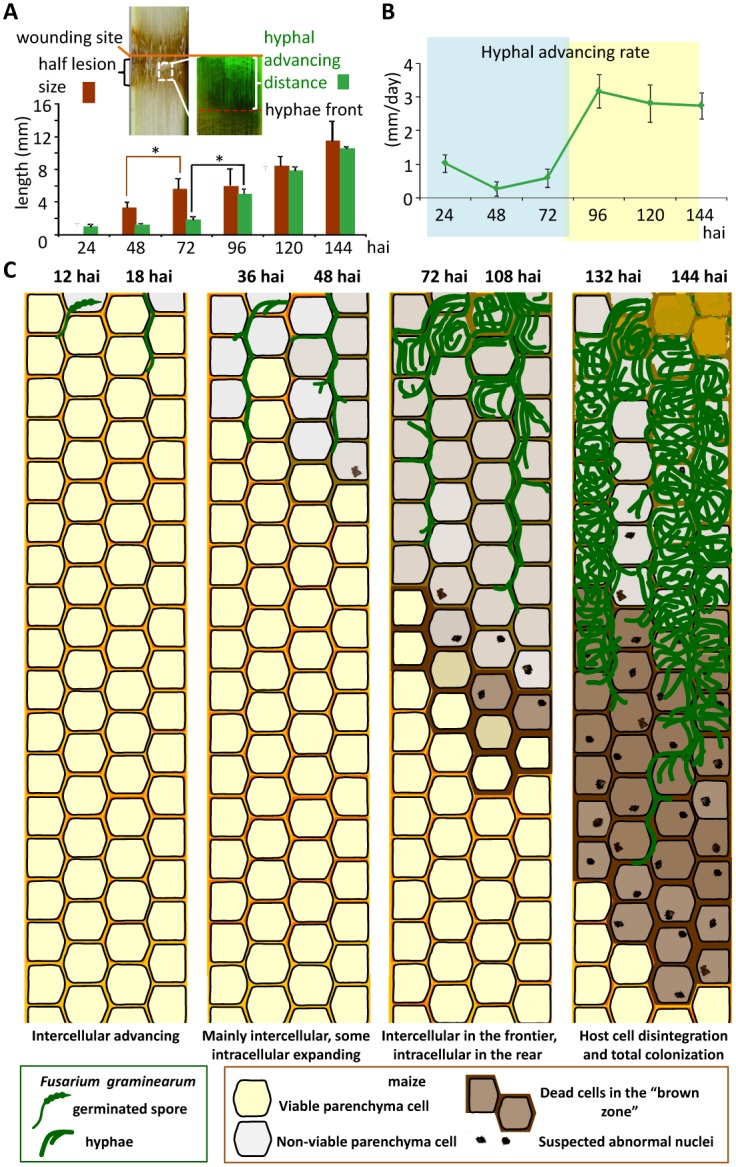
Measurements and diagram of maize stalk infection process.(A) Measurements of half lesion size and hyphal advance distances. Error bars indicate SD. *Significant difference by Student’s t-test (P < 0.05). Sample size n ≥3. (B) The advance rates of the hyphal front calculated based on the data in (A). (C) Diagram of cellular events during the advance of F. graminearum in stalk pith mainly composed of parenchyma cells. The top of each column represents the wound site. F. graminearum grew up and down in the stalk in a similar pattern and with a similar expansion speed; for simplicity only the downside from the wound site is shown. Cell viability was judged based on plasmolysis assay. hai: hours after inoculation.